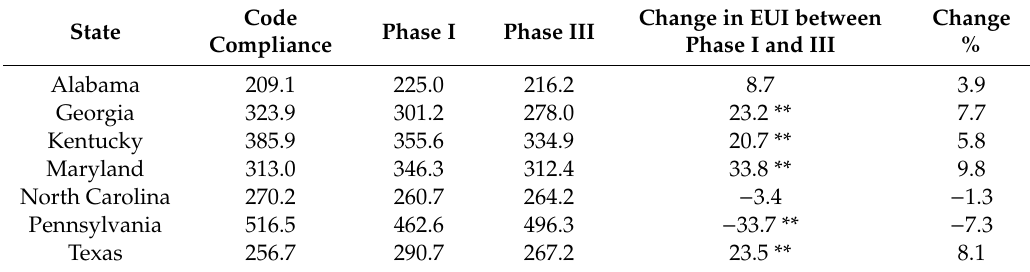
Table 4. Energy-Use Intensity (EUI) [MJ / m 2